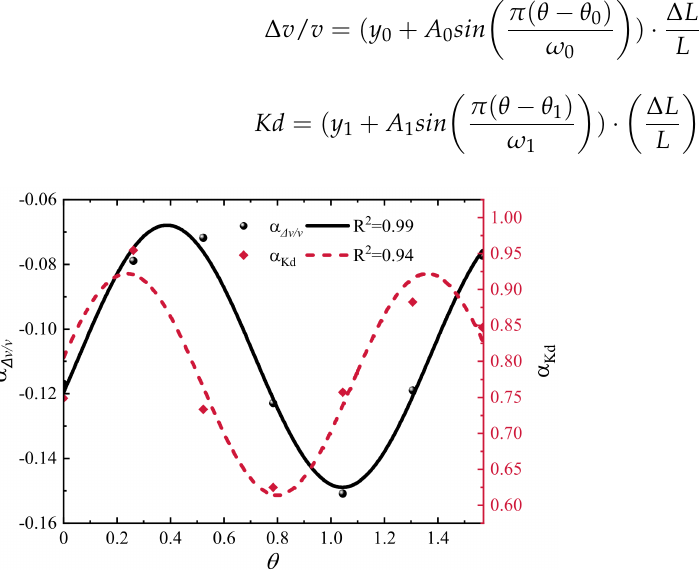
Figure 9. Slopes of CWI observations with crack length changes versus θ